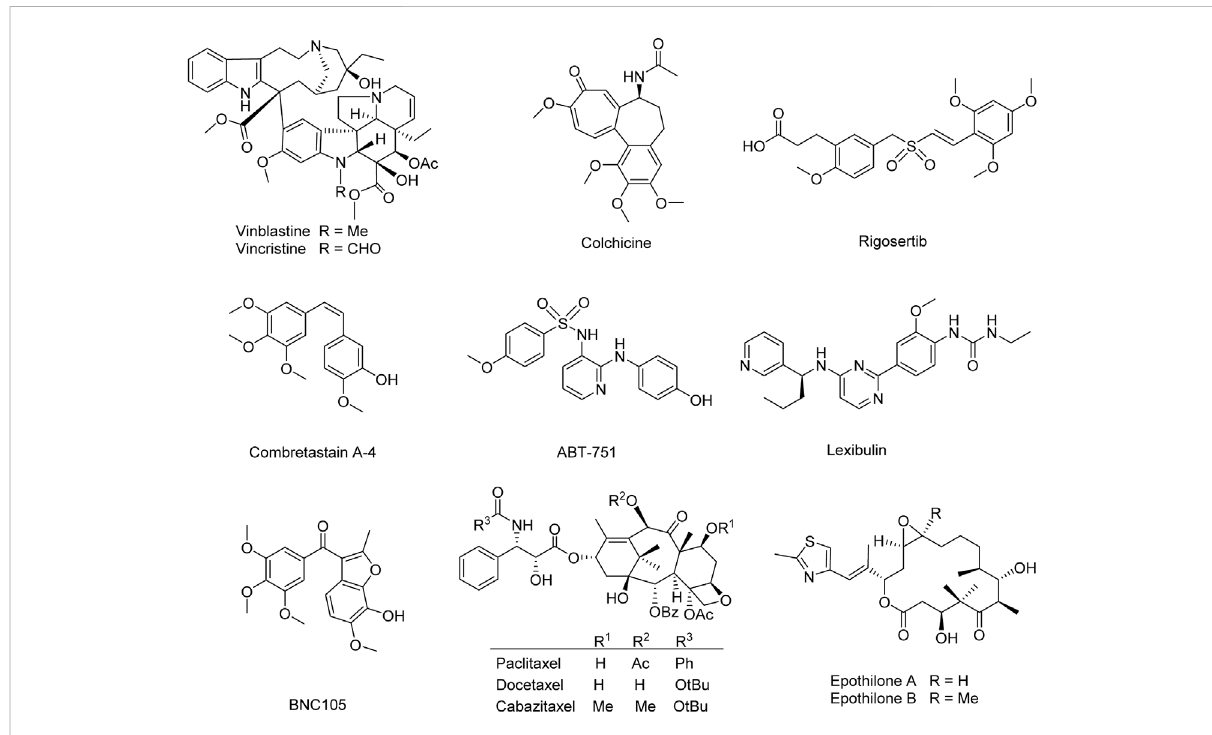
FIGURE 1 Microtubule-targeting agents for the treatment of